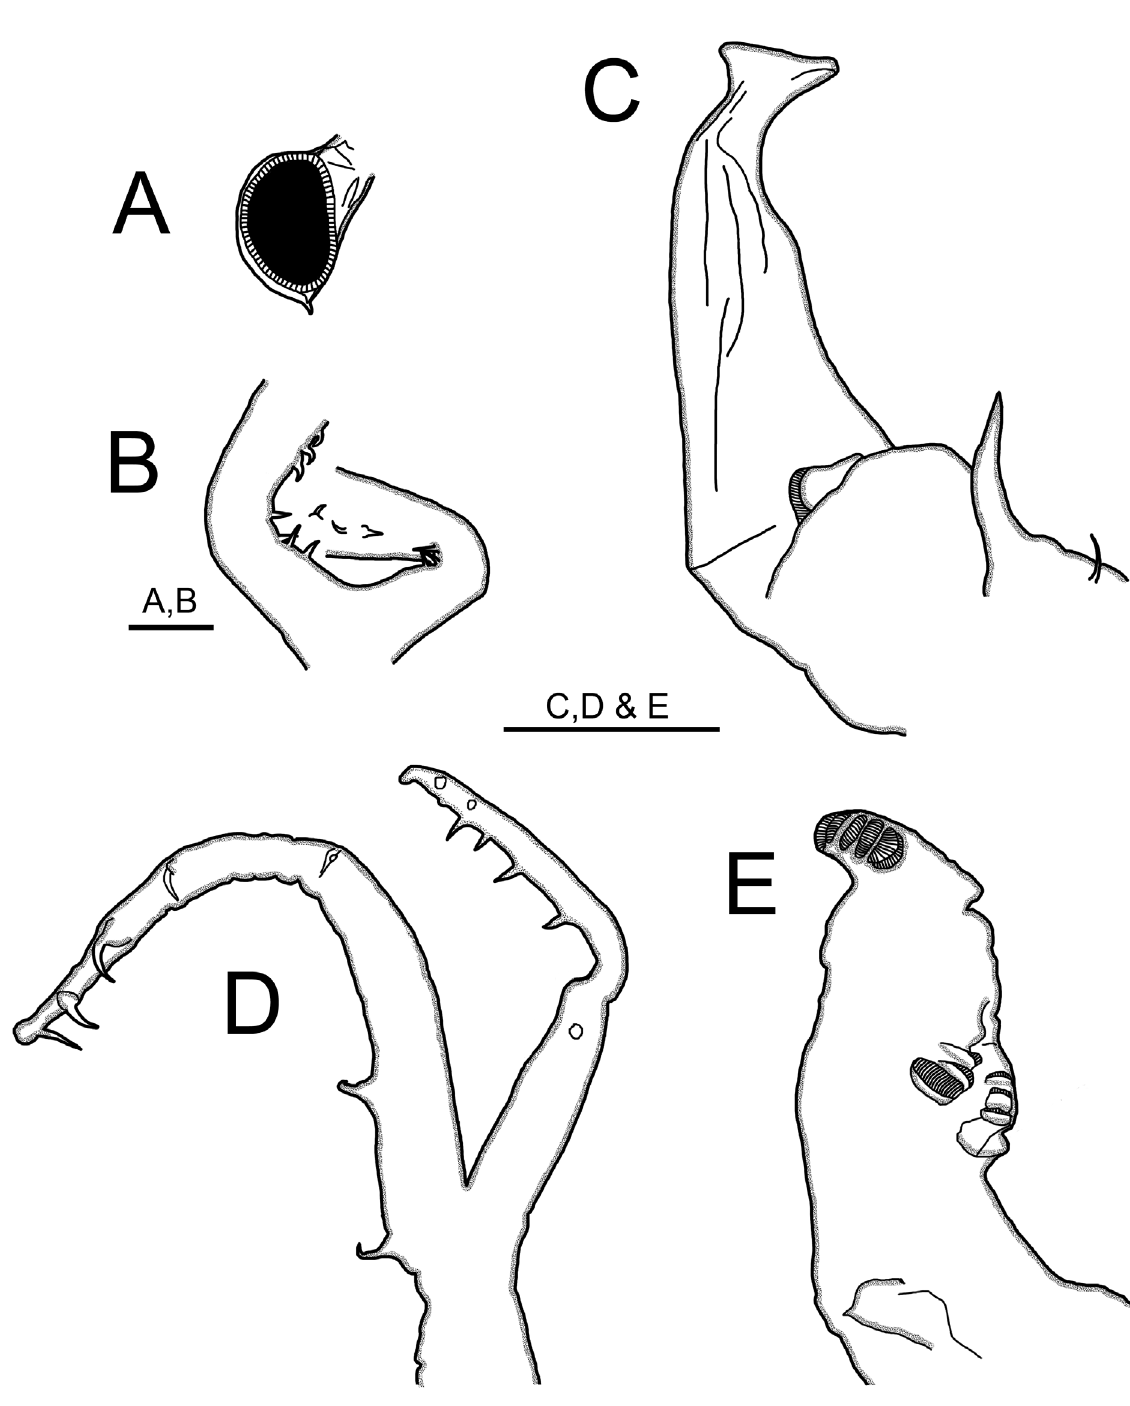
Fig. 5. Dendrocephalus xikrini Rabet & Bozelli sp. nov., ♂. A . Eye with a spine on the posterior edge. B . Basal part of the frontal appendage. C . Branch 2A of the frontal appendage. D . Branch 1V. E . Branch 2V. Scale bars: 1